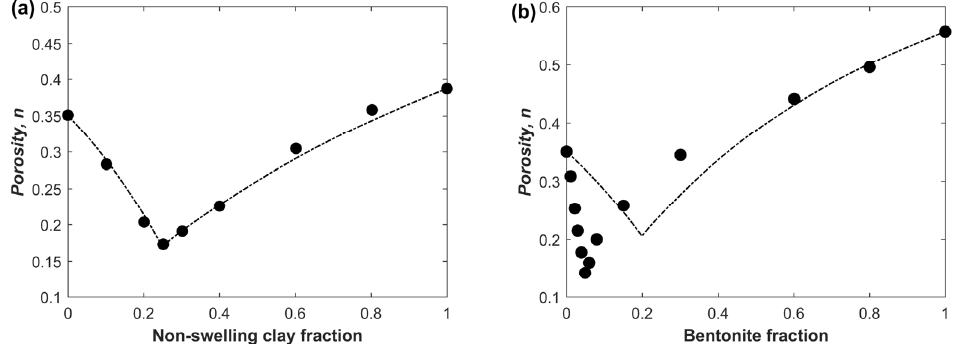
Figure 6. Porosity as function fines fraction for: ( a ) mixtures of Fujian sand and Jiangning non- swelling clay (clay-J), ( b ) mixtures of Fujian sand and bentonite. Experimental results (black circles) are reported by Xu et al. [7]. Dashed black curves correspond to the predictions of the model discussed above (Equations (1), (2) and (7)–(9)) without incorporation of swelling